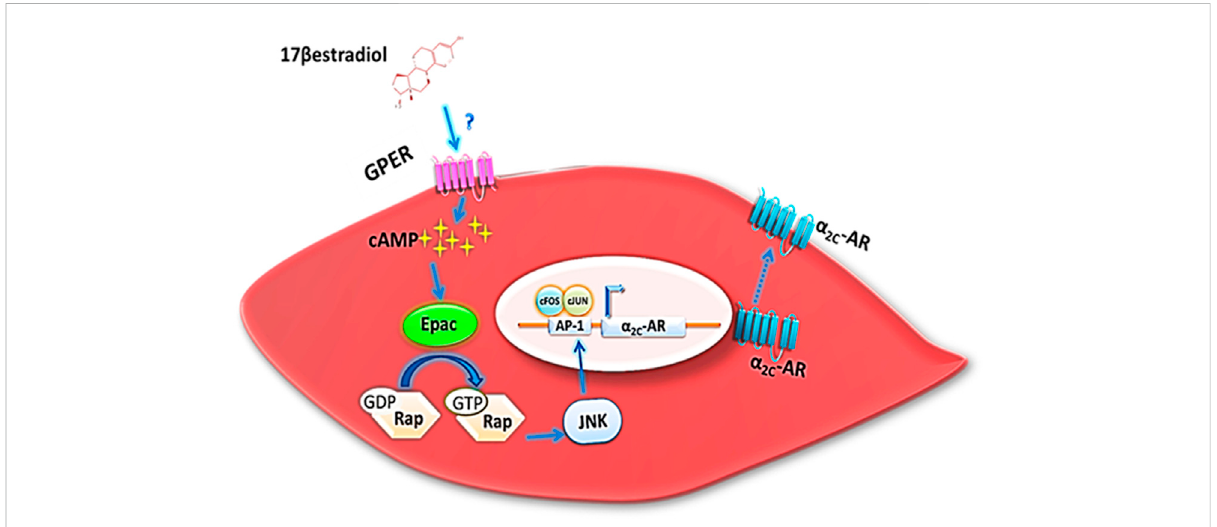
FIGURE 1 Activation of GPER by estrogen initiates a signaling cascade leading to α 2C -AR upregulation. GPER mediates estrogen-induced elevation of cAMP level. This elevation is sensed by cAMP downstream effector, Epac. Epac then switches on its target, Rap. Activated GTP-bound Rap induces JNK,whichinturnleadstotheformationofactivatorprotein(AP-1)bythedimerizationofthec-Fosandc-Jun.AP-1bindsto AP-1siteinthe α 2C -AR promoter, initiating its transcription. ( α 2C -AR, alpha 2C-adrenoceptors; cAMP, cyclic adenosine monophosphate; Epac, exchange proteins activatedbycAMP;Rap,Ras-relatedprotein1;JNK,c-JunN-terminalkinase;AP-1,activatorprotein-1;GPER,G-proteincoupledestrogenreceptor; VSMC, vascular smooth muscle